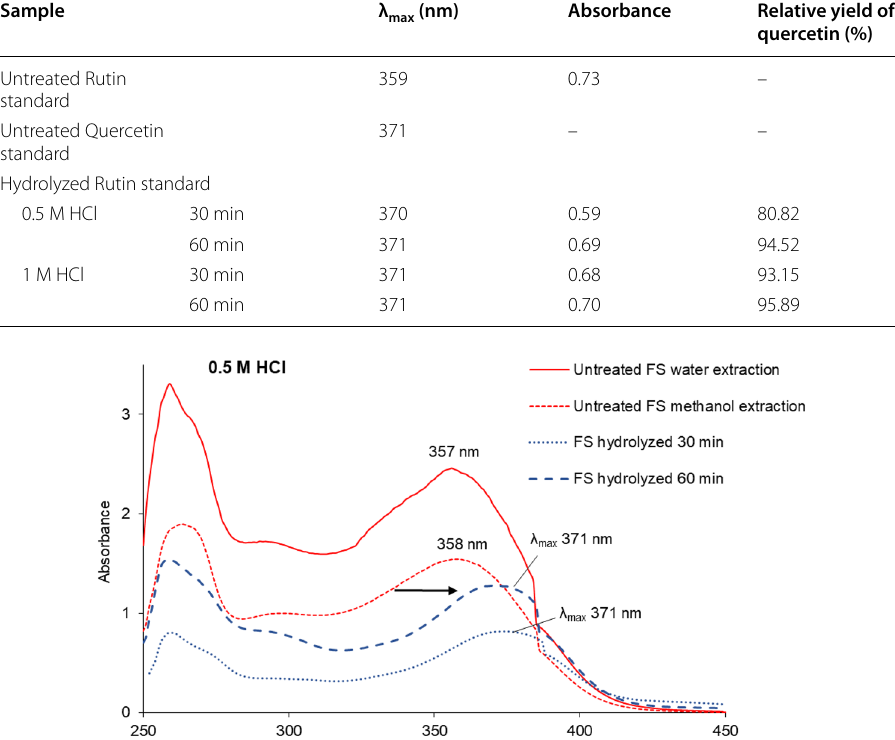
Table 4 Result of hydrolysis of Rutin standard Sample λ max (nm) Absorbance Relative yield of